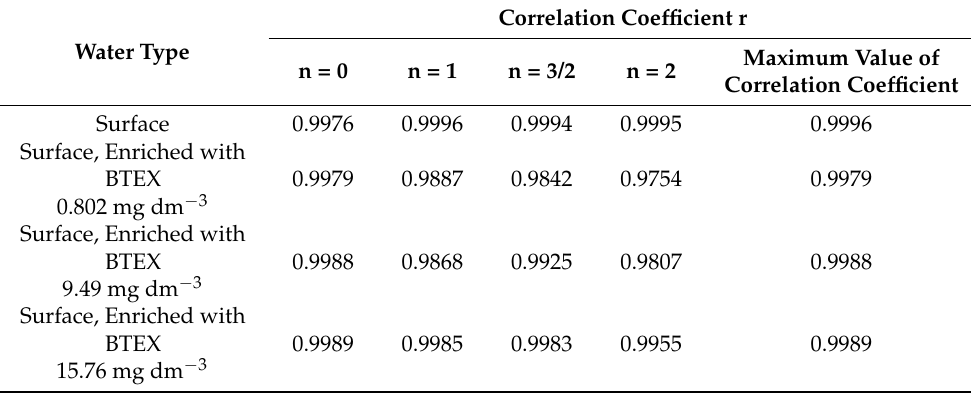
Table 4. Correlation coefficient (r) of fitting the experimental curve and model curves (according to Hermia) depending on the value of n for the filtration process of unmodified surface water and surface water with added BTEX.